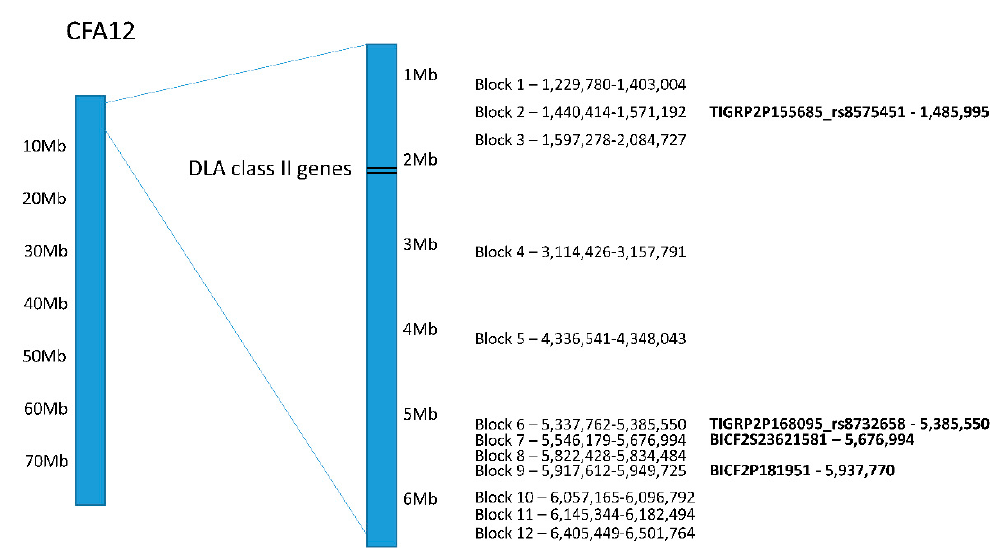
Figure 3. Distribution of haplotype blocks on CFA12 with permutation p -values < 0.01 as determined by Haploview. The top genome-wide significant SNPs that were part of the haplotype blocks are in bold text shown on the right with their location.